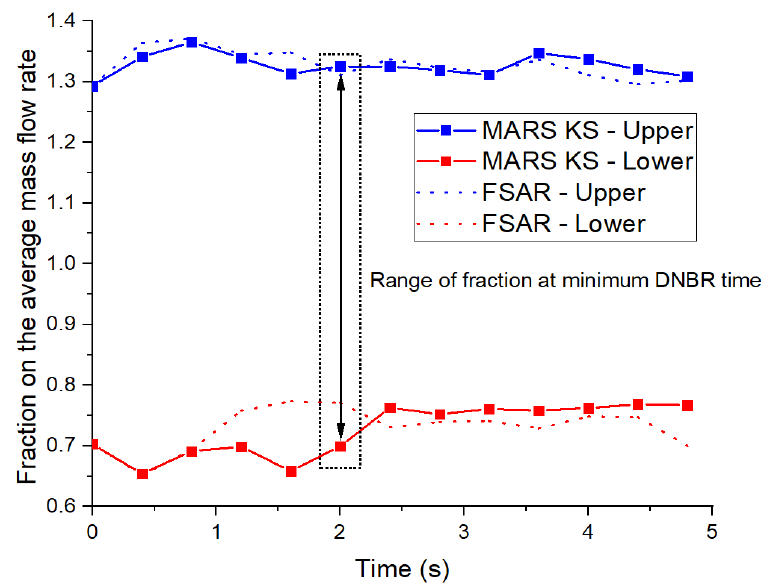
Figure 7. Minimum DNBR for five transient seconds using MARS-KS.